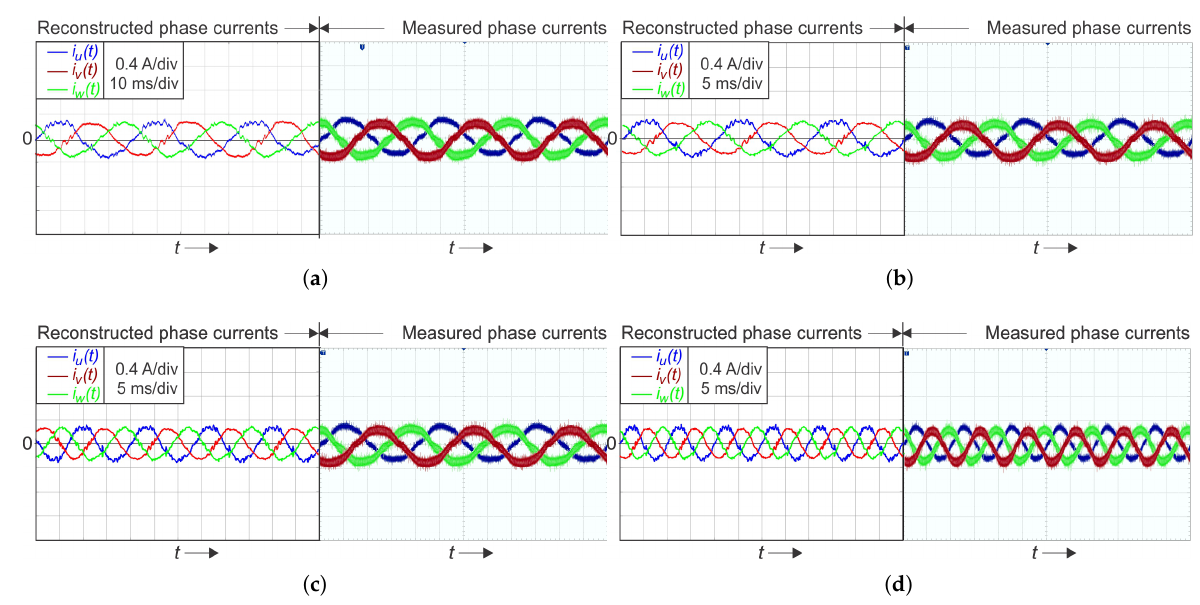
Figure 10. Single-shunt reconstruction of a three-phase current using SVM for low modulation index m i = 0.050 at a current magnitude of ˆ i u = ˆ i v = ˆ i w = 0.3 A: ( a ) reconstructed and oscilloscope- measured currents at f = 25 Hz; ( b ) at f = 50 Hz; ( c ) at f = 75 Hz; ( d ) at f = 100 Hz.